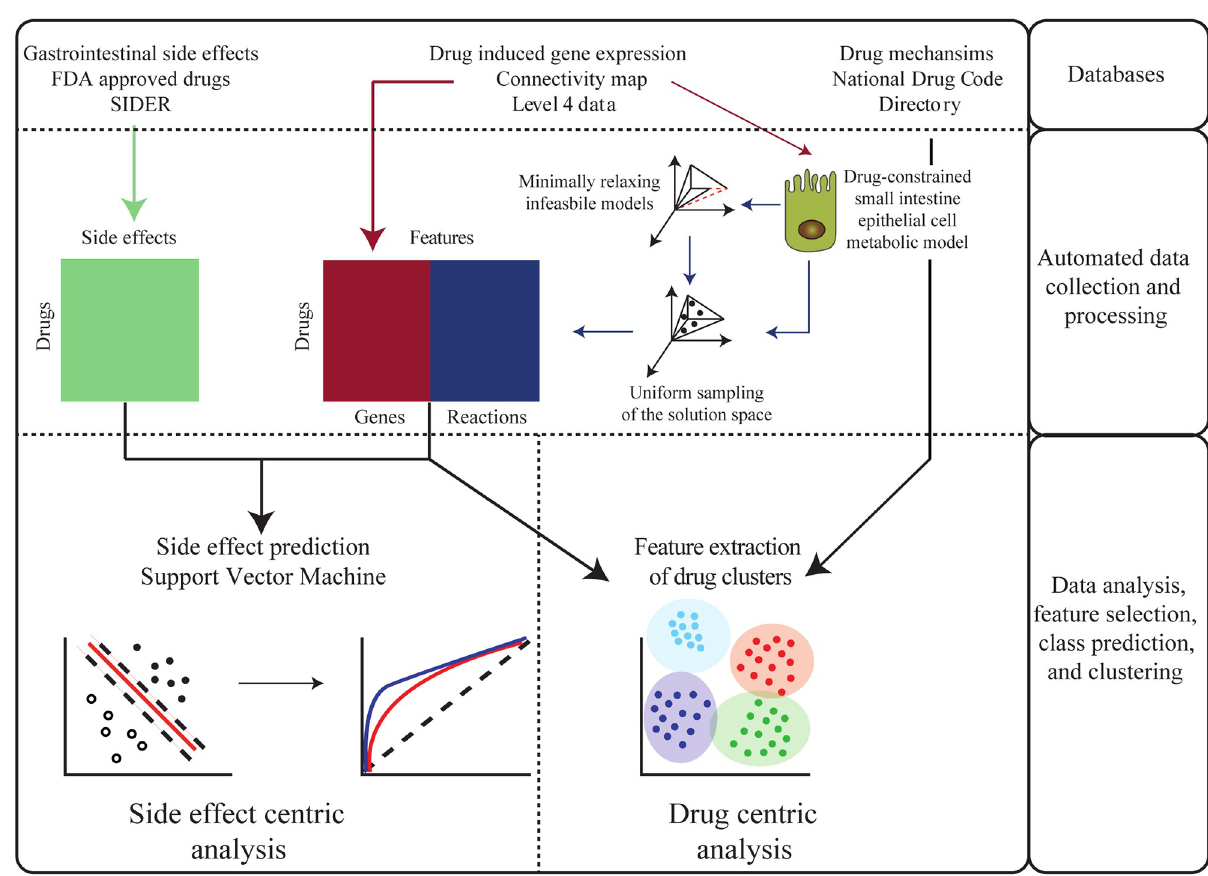
Fig 1. Overview of the pipeline of data generation and analysis in this study. Drug-induced gene expression data was collected through the connectivity map API for 978 genes [6]. The drug side effects occurrence was obtained from the SIDER database, and the drug mechanism and physiological effects were collected from the FDA National Drug Code Directory (NDCD). The drug-induced gene expression was subjected as constraints to an sIEC metabolic model to derive a context-specific model for each drug, to enable the prediction of the enterocyte’s metabolic phenotype after the action of the drug. After minimally resolving infeasible models, the uniform sampling of the solution space of the sIEC provides distributions of fluxes for each reaction and could be used to derive z-scores for the 1282 metabolic reactions in a given drug-constrained model and the drug-free model. Combining the drug-induced gene expression with predicted differential metabolic fluxes in a single matrix was used to train and cross-validate a multilabel support vector machine, using the SIDER side effect labels as the class binary matrix (M), where if drug j causes side effect i , M ( i , j ) = 1, and 0 otherwise. Such classifier can be used to predict the likelihood of occurrence of side effects of newly developed drugs based on their in vitro transcriptomic fingerprint and their in silico predicted metabolic profile in the enterocyte. Finally, the clustering of drugs based on their transcriptomic and metabolic profiles can be used to identify hidden similarities between the compounds that go beyond the chemical or pharmacological class-based